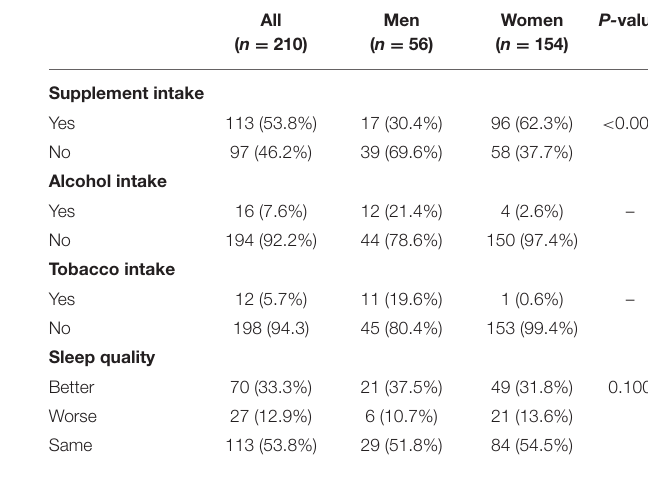
TABLE 2 | Percentages of supplement intake, alcohol intake and tobacco intake, and sleep quality during